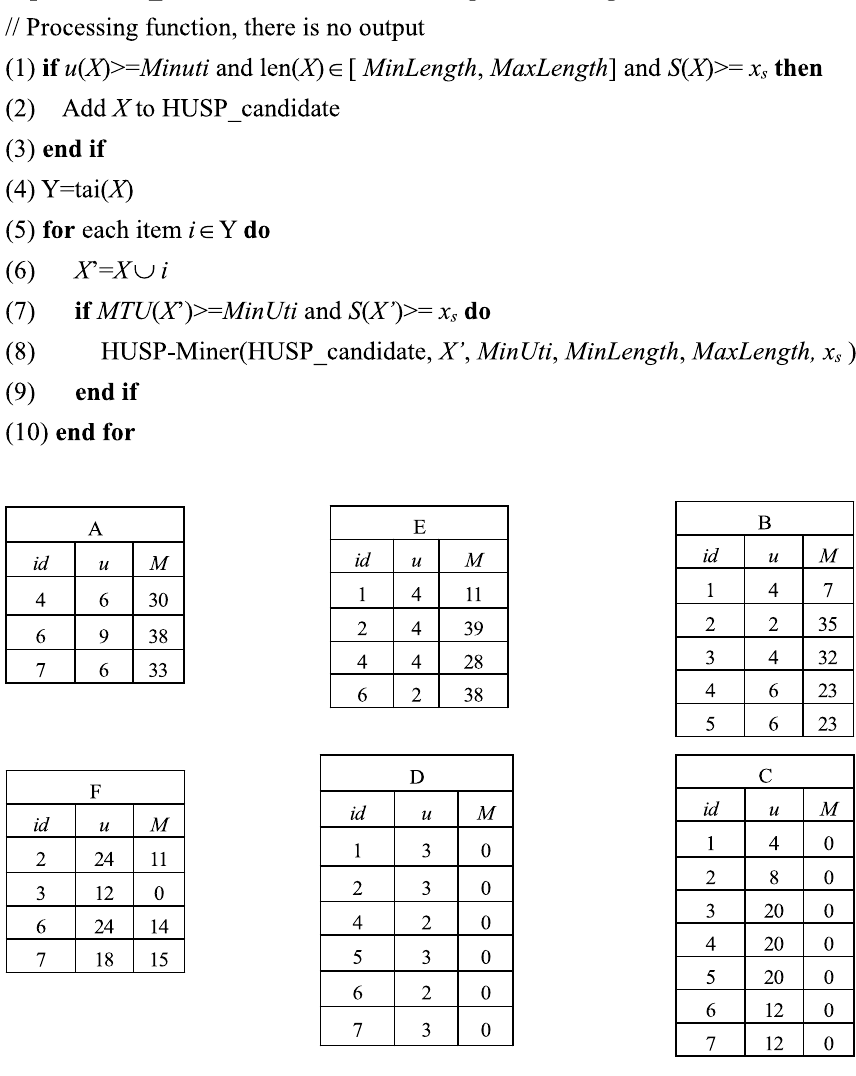
Fig. 2 Procedure of HUSP- Miner